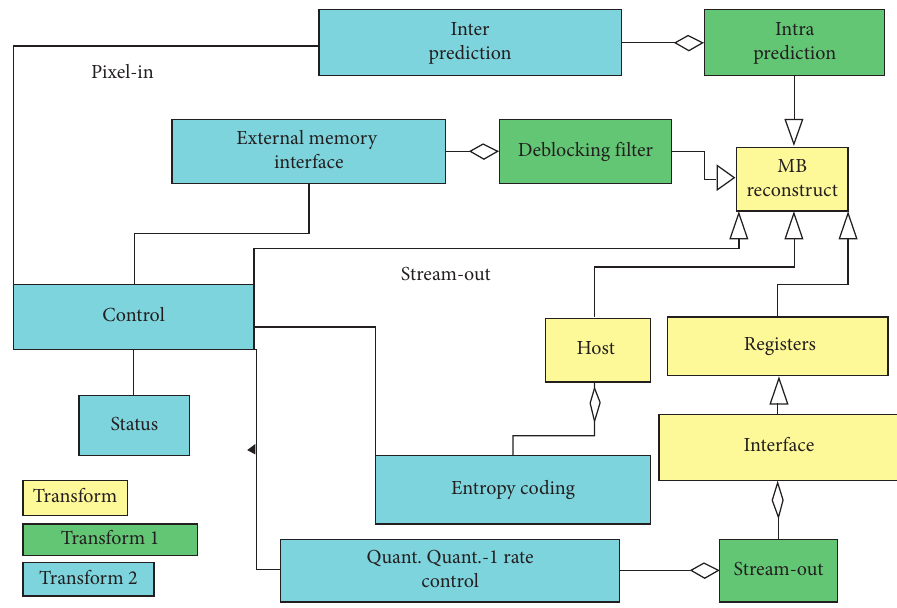
Figure 3: Microsensor information flow